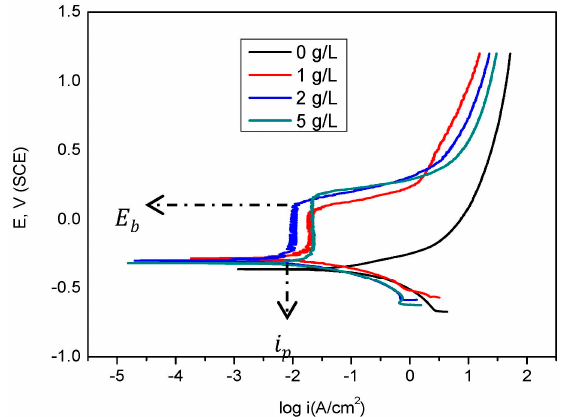
Figure 1. Polarization curves for mild steel in bicarbonate/chloride solution in absence and presence of different concentration of sodium nitrite at 2000 rpm at room temperature.